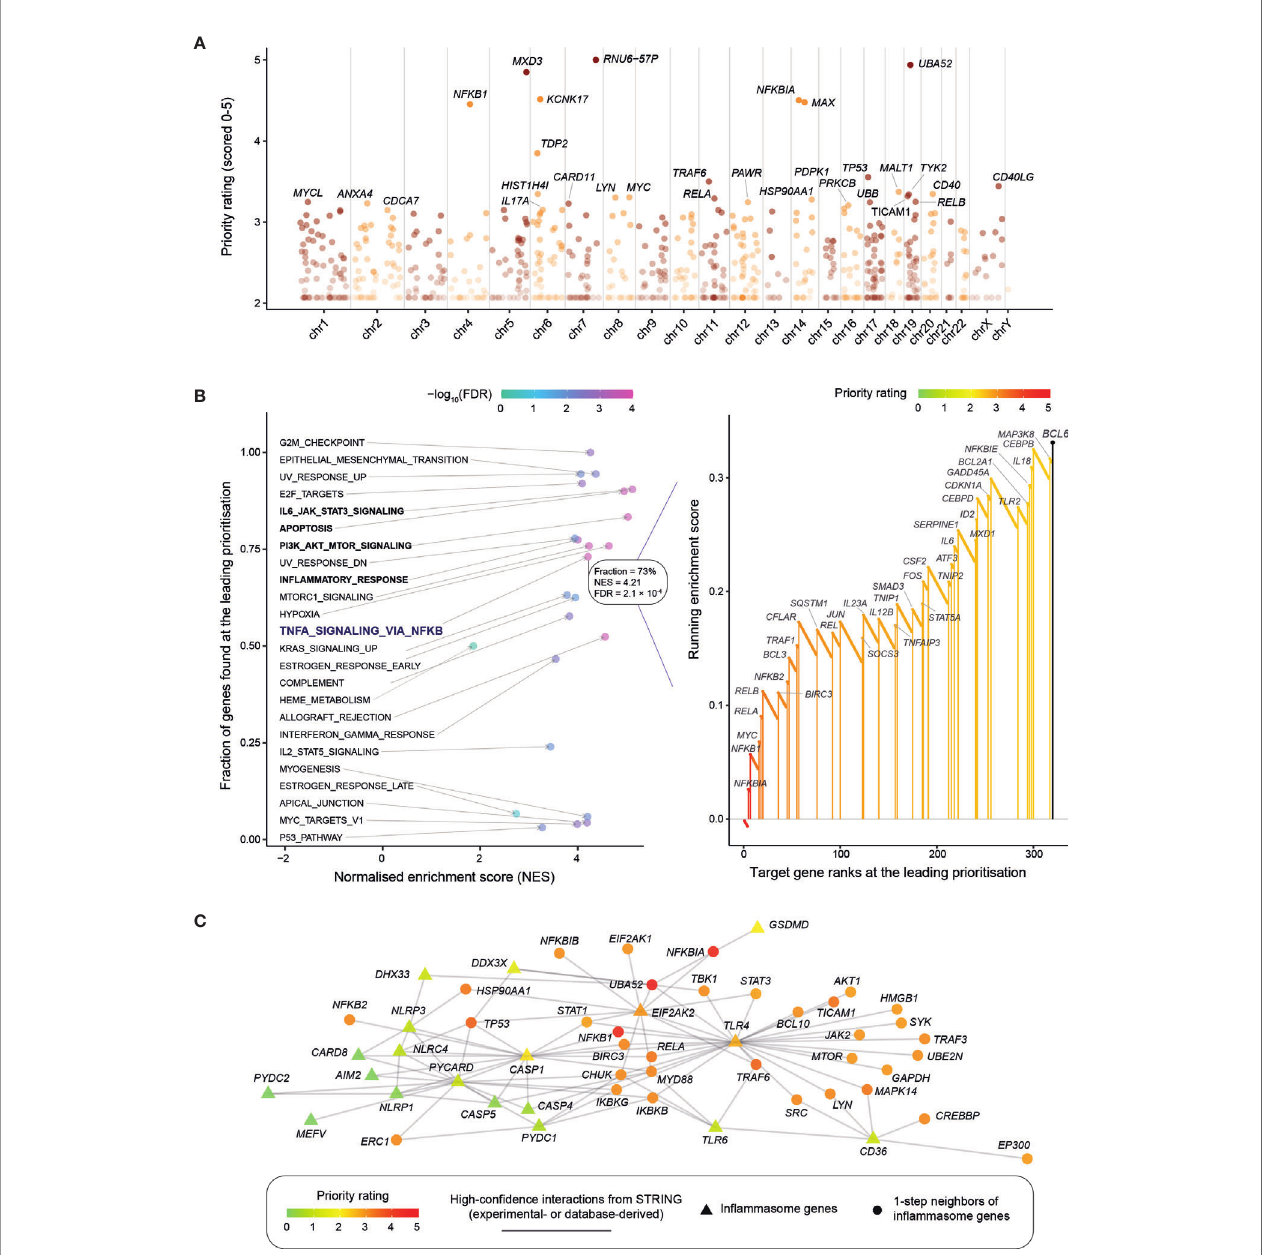
FIGURE 1 | Genetic prioritization and characterization of target genes in kidney stone disease. (A) Overview of target gene prioritization. Manhattan plot illustrates priority rating ( y -axis) for prioritized target genes (color-coded by chromosomes; x -axis), with top 30 genes named. (B) Target set enrichment analysis (TSEA) using the hallmark gene sets. Left panel : Scatter plot showing TSEA results, with each dot for a gene set and colored by FDR. Right panel : Illustration of the leading prioritization for the gene set “ TNFA_SIGNALING_VIA_NFKB ” (that is, genes regulated by NF-kB in response to TNF). The leading prioritization is de fi ned as the left- most region ahead of the peak, as indicated by the dark blue bar. Genes found at the leading prioritization are indicated in vertical lines (also color-coded by priority rating). (C) In fl ammasome. Interactions between in fl ammasome genes are visualized, together with their one-step (direct) neighbor genes (restricted to the top 1% prioritized genes). Gene nodes are colored by priority rating and shaped by whether or not functionally relevant to in fl ammasome. Gene interactions are sourced from the STRING database, while the relatedness to in fl ammasome obtained from annotations using Gene